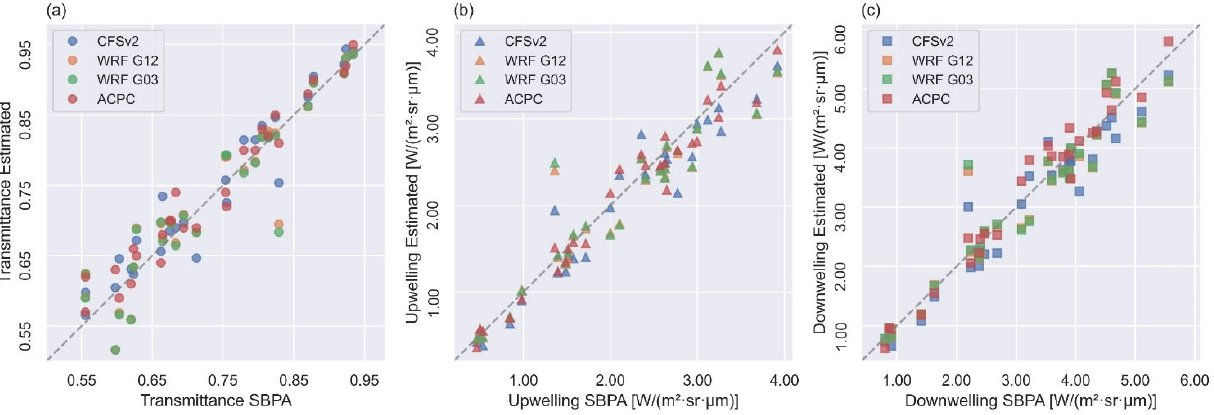
Figure 2. Comparison of ( a ) atmospheric transmittance, ( b ) upwelling radiance, and ( c ) downwelling radiance calculated with SBPA in situ radiosondes and estimated profile sources. The dashed line represents the “1:1 line”. Table 3. Statistical metrics of atmospheric parameters estimated from different atmospheric profiles. Bias, MAE, and RMSE are in the units of the parameter of interest, i.e., W ∙ m − 2 ∙ sr − 1 ∙μ m − 1 for atmospheric radiances and the transmittance is dimensionless.